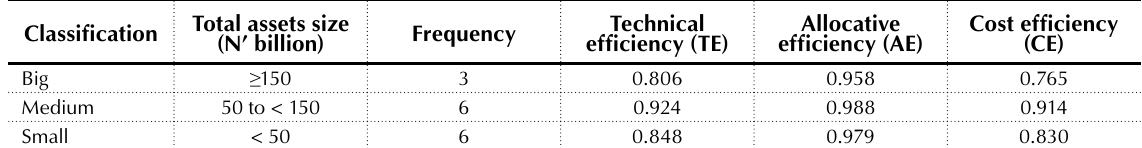
Table 2. Measured mean efficiency of the deposit money banks in 2002